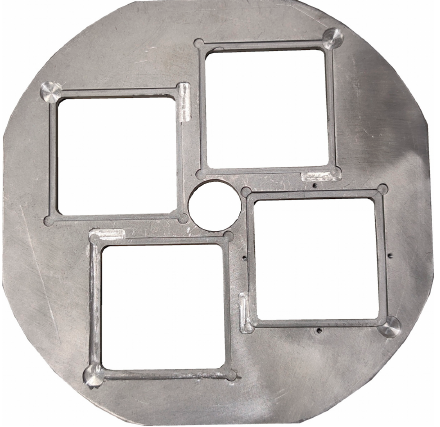
Figure 3. Mechanical support for the substrates.